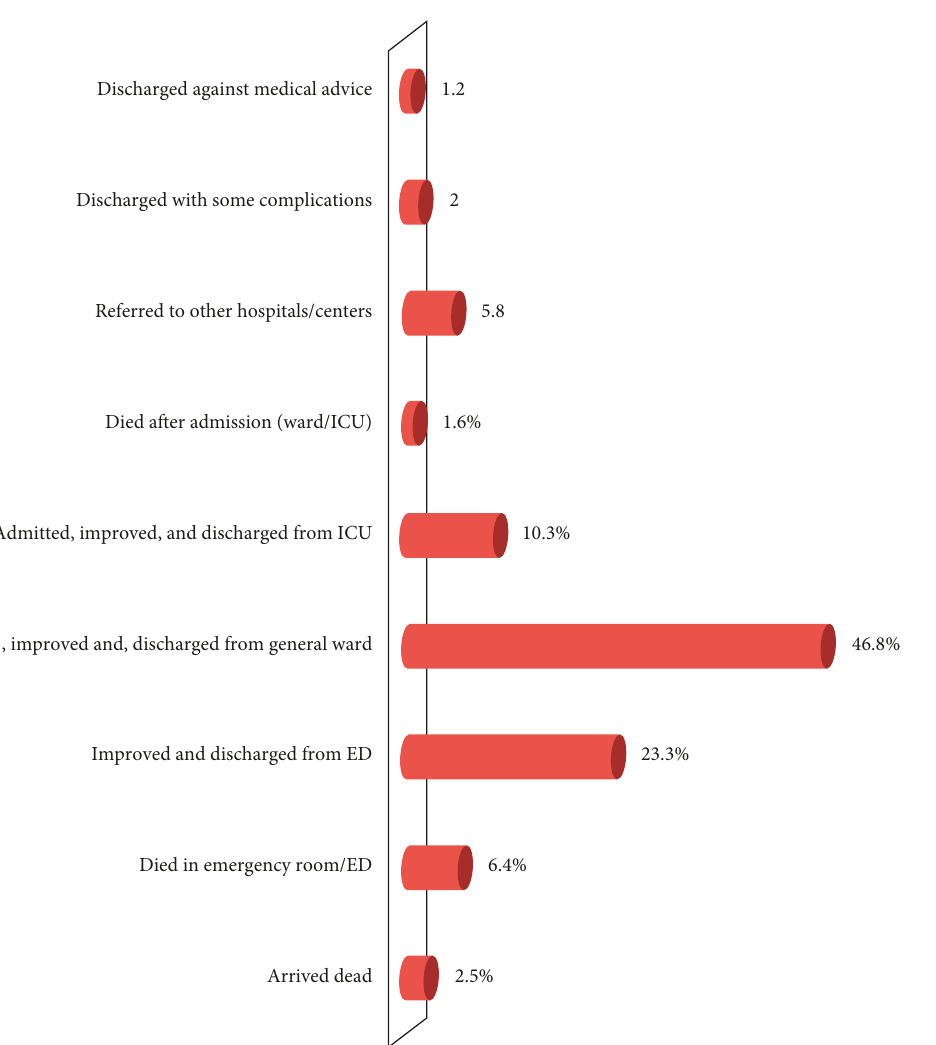
Figure 4: Distribution of respondents by their consequences of emergency department visits in Nekemte, western Ethiopia,